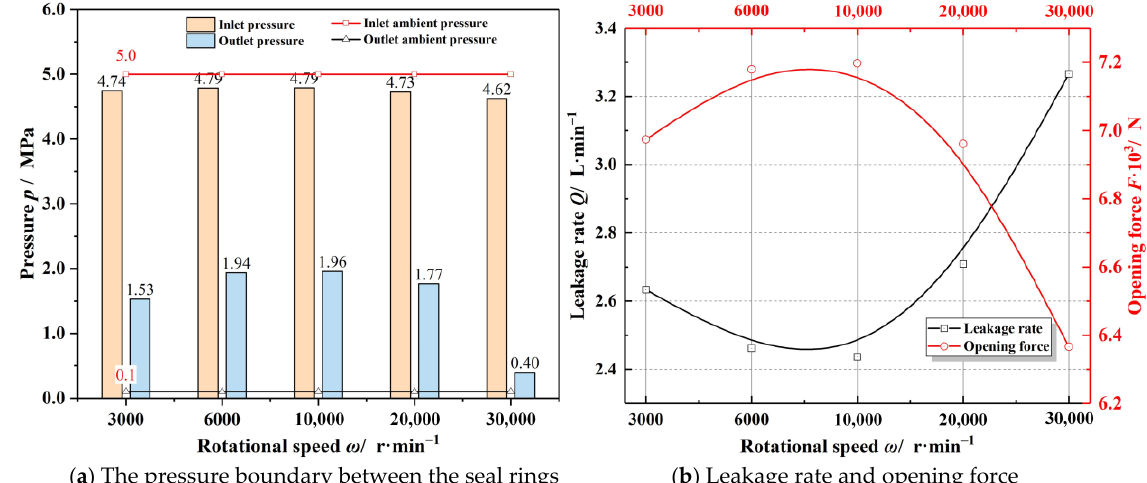
Figure 8. Influence of rotational speed on sealing performance ( h 0 = 3.0 μm, p o = 5.0 MPa, T o = 200 K).